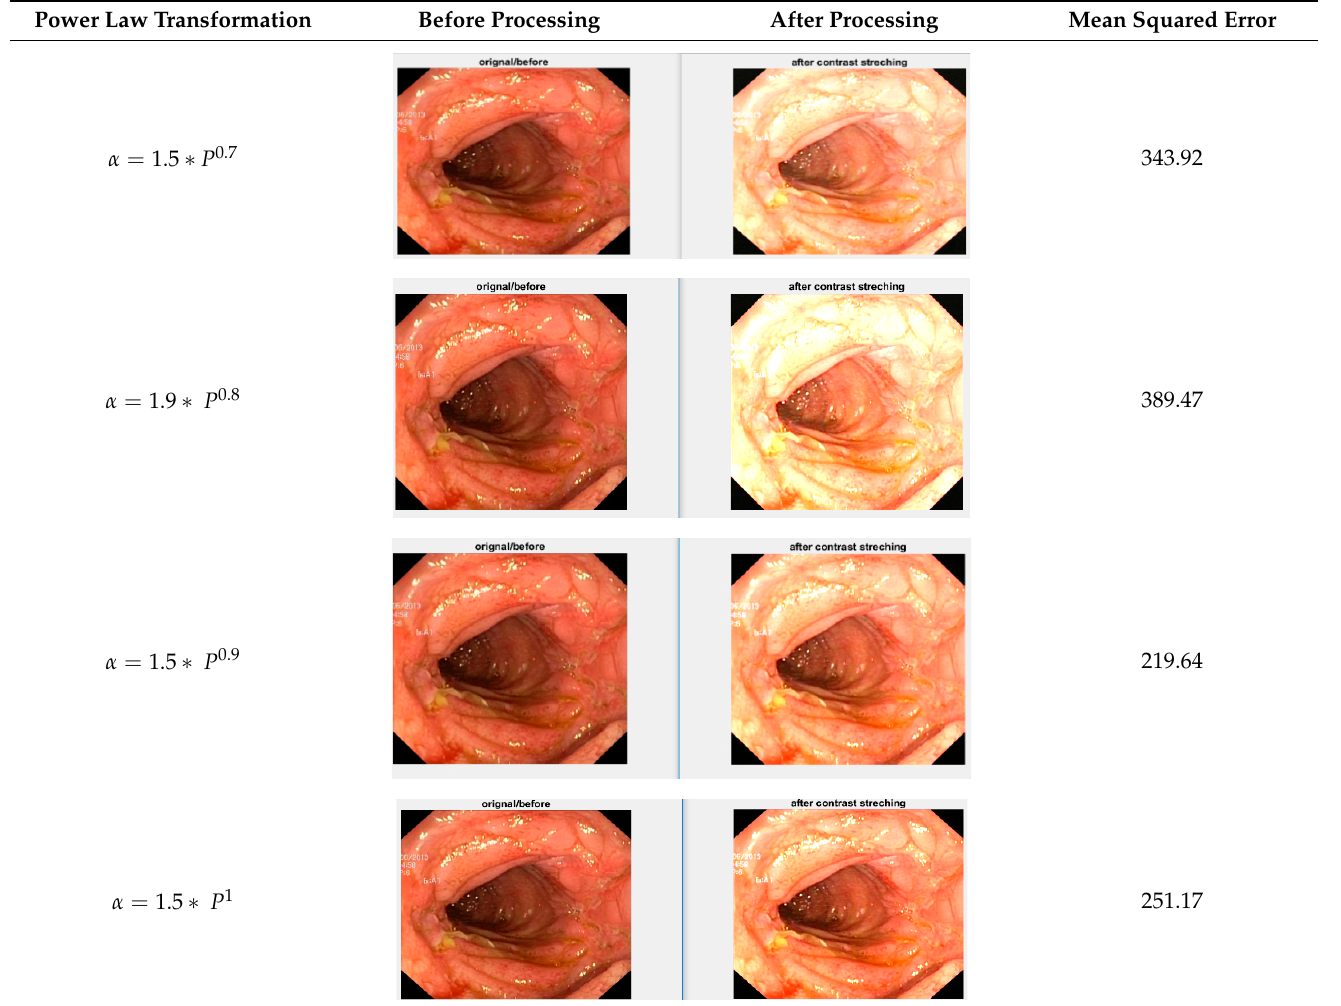
Figure 3. System architecture after applying power law transformation.